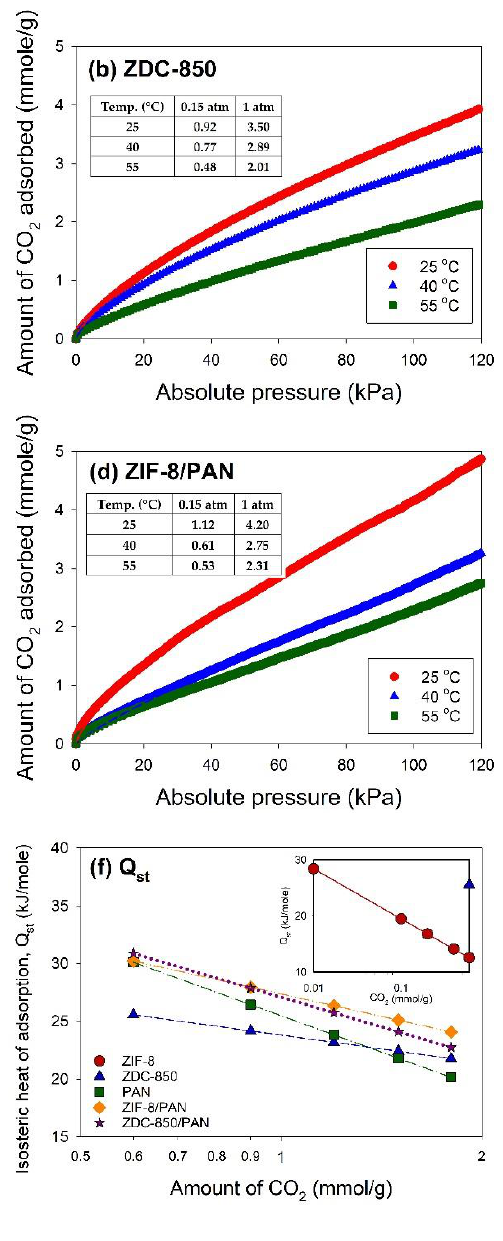
Figure 7. Adsorption isotherms of CO 2 of the samples: ( a ) ZIF-8; ( b ) ZDC-850; ( c ) PAN; ( d ) ZIF-8/PAN; ( e ) ZDC-850/PAN; and ( f ) the isosteric heat of adsorption of CO 2 on the samples.